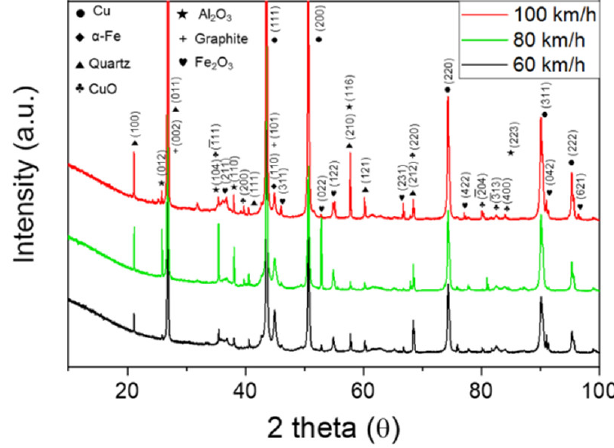
Figure 12. XRD spectra of surfaces of Cu-based brake pads after dynamometer test performed at different wheel running speeds.